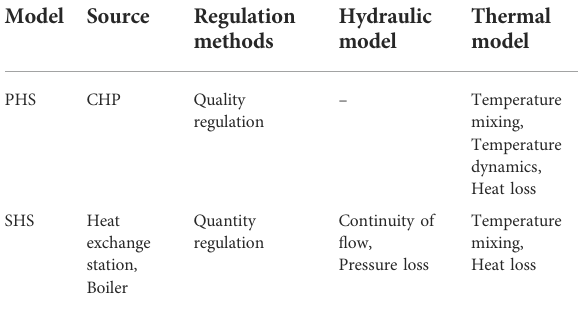
TABLE 1 Difference between the primary and secondary heating systems.